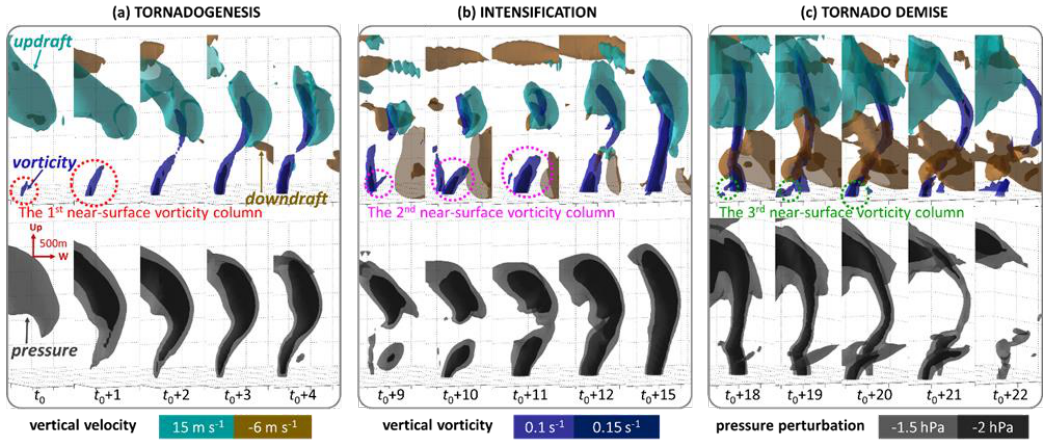
Figure 8. Structure and development of rotational column (upper row) versus pressure perturbation core (lower row) during stages of ( a ) tornadogenesis, ( b ) intensification and ( c ) demise. The isosurface of 0.1 s −1 vertical vorticity is given in dark blue, embedded with a darker blue isosurface denoting 0.15 s −1 . The updraft of the mesocyclone of 15 m s −1 is shown in cyan, while the downdraft of −6 m s −1 is in brown. The dark grey and black isosurfaces in the lower row depict the pressure perturbation of − 1.5 and − 2 hPa, respectively. The distance scales in the vertical and horizontal directions are given in ( a ).